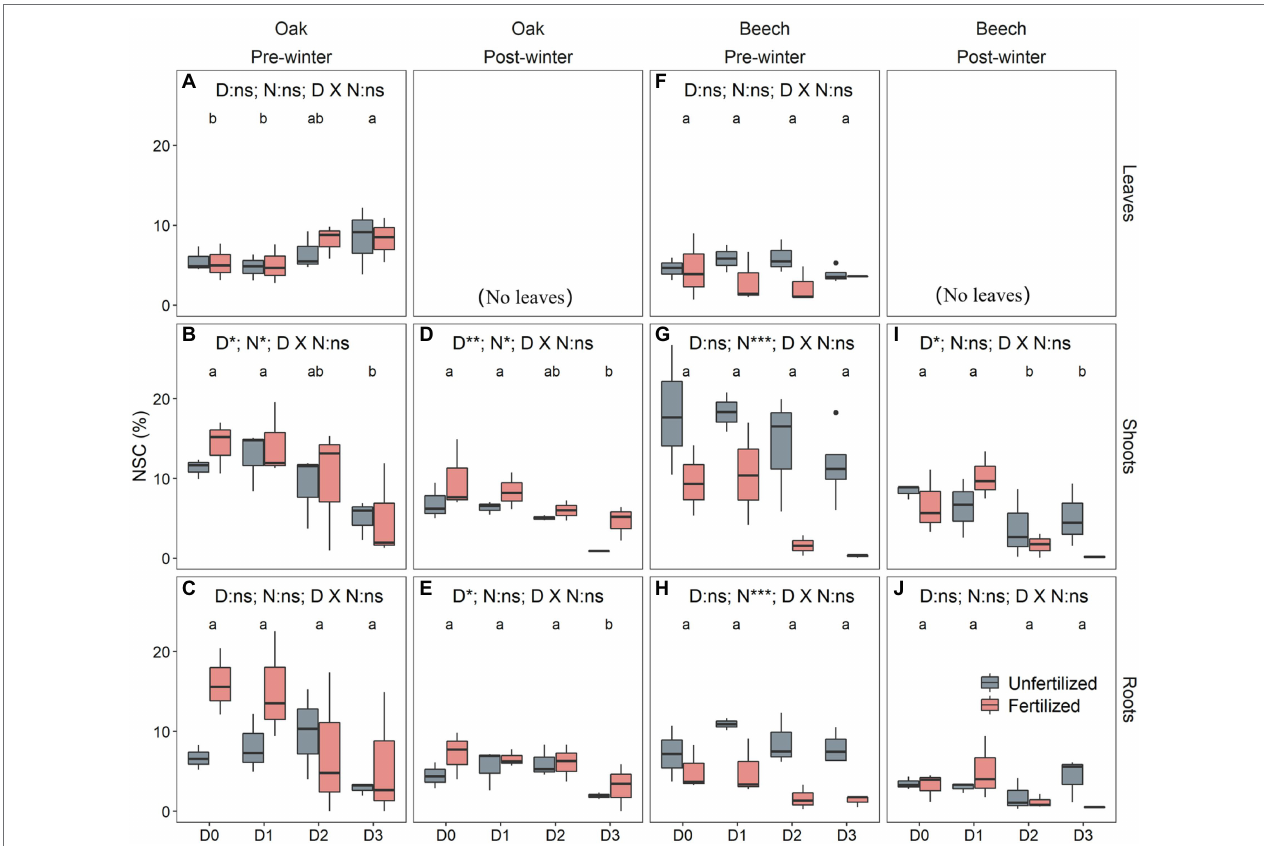
FIGURE 3 | Non-structural carbohydrate (NSC) concentrations in leaves (A,F) , shoots (B,D,G,I) , and roots (C,E,H,J) of oak ( Quercus petraea ) (A–E) and beech ( Fagus sylvatica ) (F–J) saplings after 4 months of drought duration treatment in 2018 (pre-winter) (A–E,F–H) and before the growing season 2019 (post-winter) (D–E,I–J) . D0 (watering weekly), D1 (watering biweekly), D2 (watering monthly), and D3 (watering bimonthly) represent the drought duration. Different letters indicate significant differences in parameters among D0, D1, D2, and